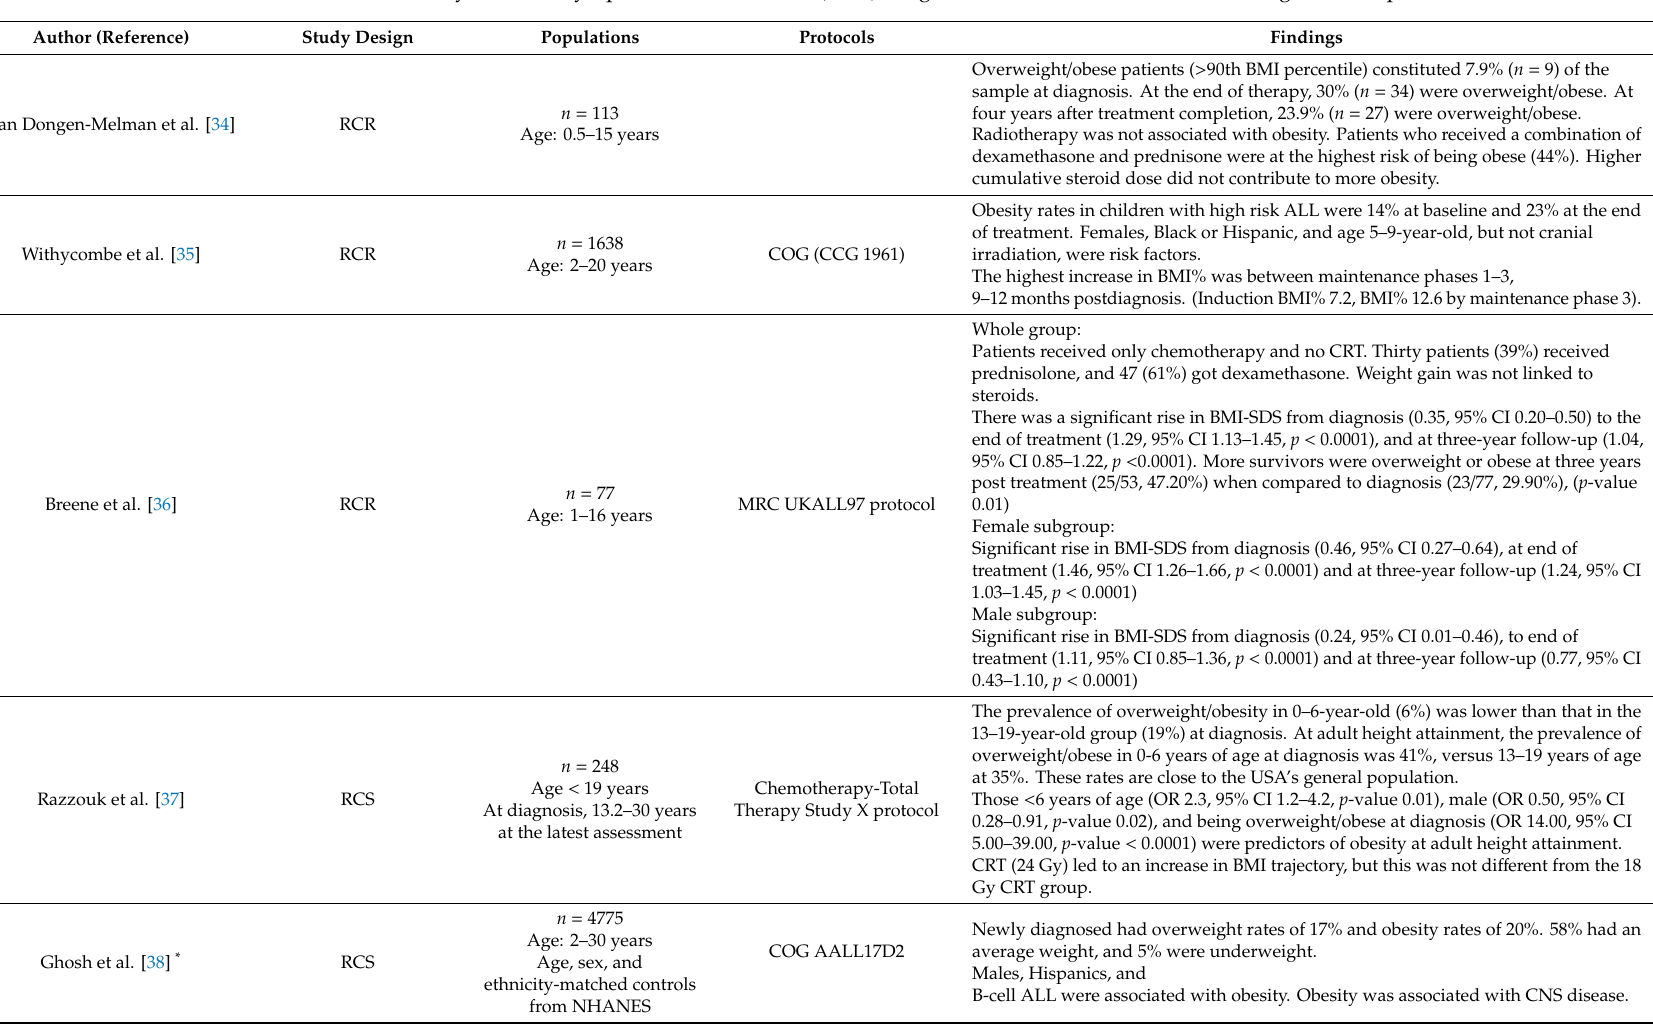
Table 1. Rates of Obesity at Acute Lymphoblastic Leukemia (ALL) Diagnosis, End of Treatment, and During